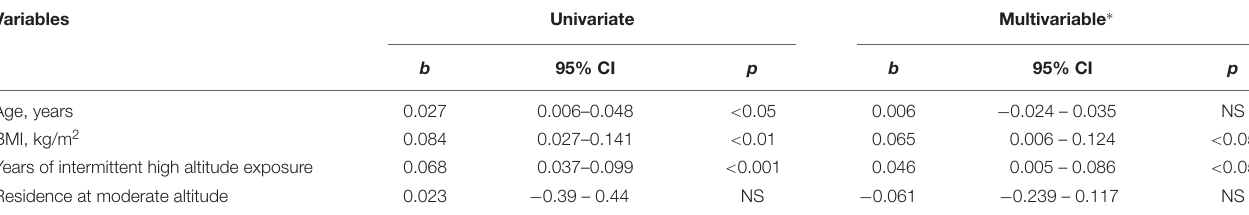
TABLE 3 | Associations between hemoglobin levels and other variables by univariate and multivariable analysis.